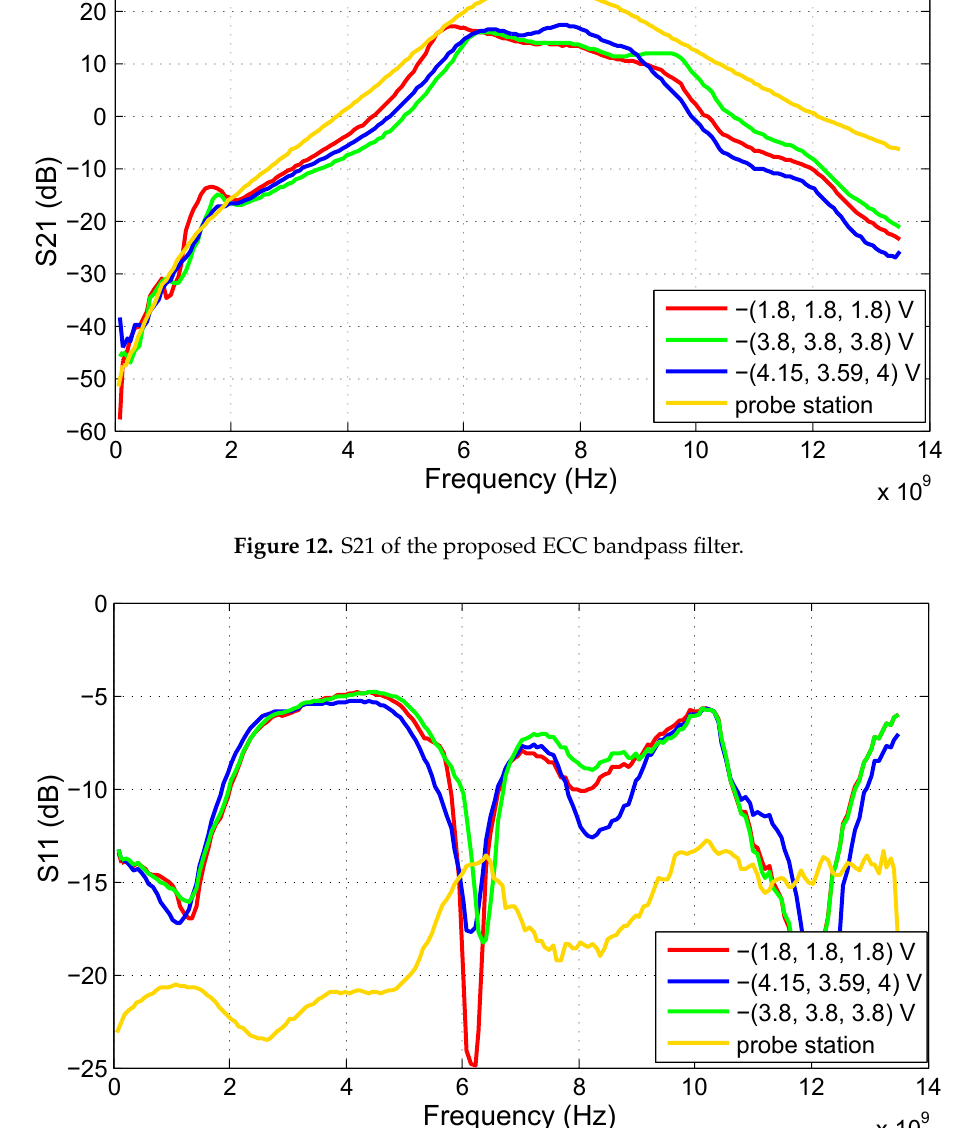
Figure 13. S11 of the proposed ECC bandpass